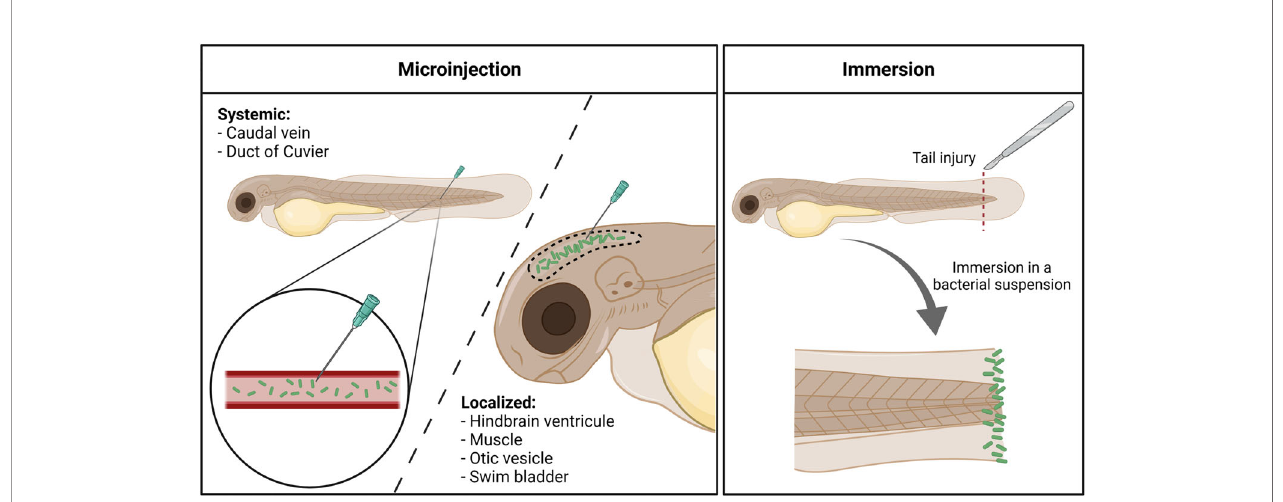
FIGURE 1 | Different infection routes used with Pseudomonas aeruginosa in the zebra fi sh embryo. Microinjection offers the possibility to induce either a systemic invasion, by delivering bacteria (in green) directly within the circulation, or a more localized infection, by injecting the pathogen in closed compartments. Immersion of tail-injured embryos in a bacterial bath induces the colonization of the fi sh tail fi n, mimicking a wound infection. Created with